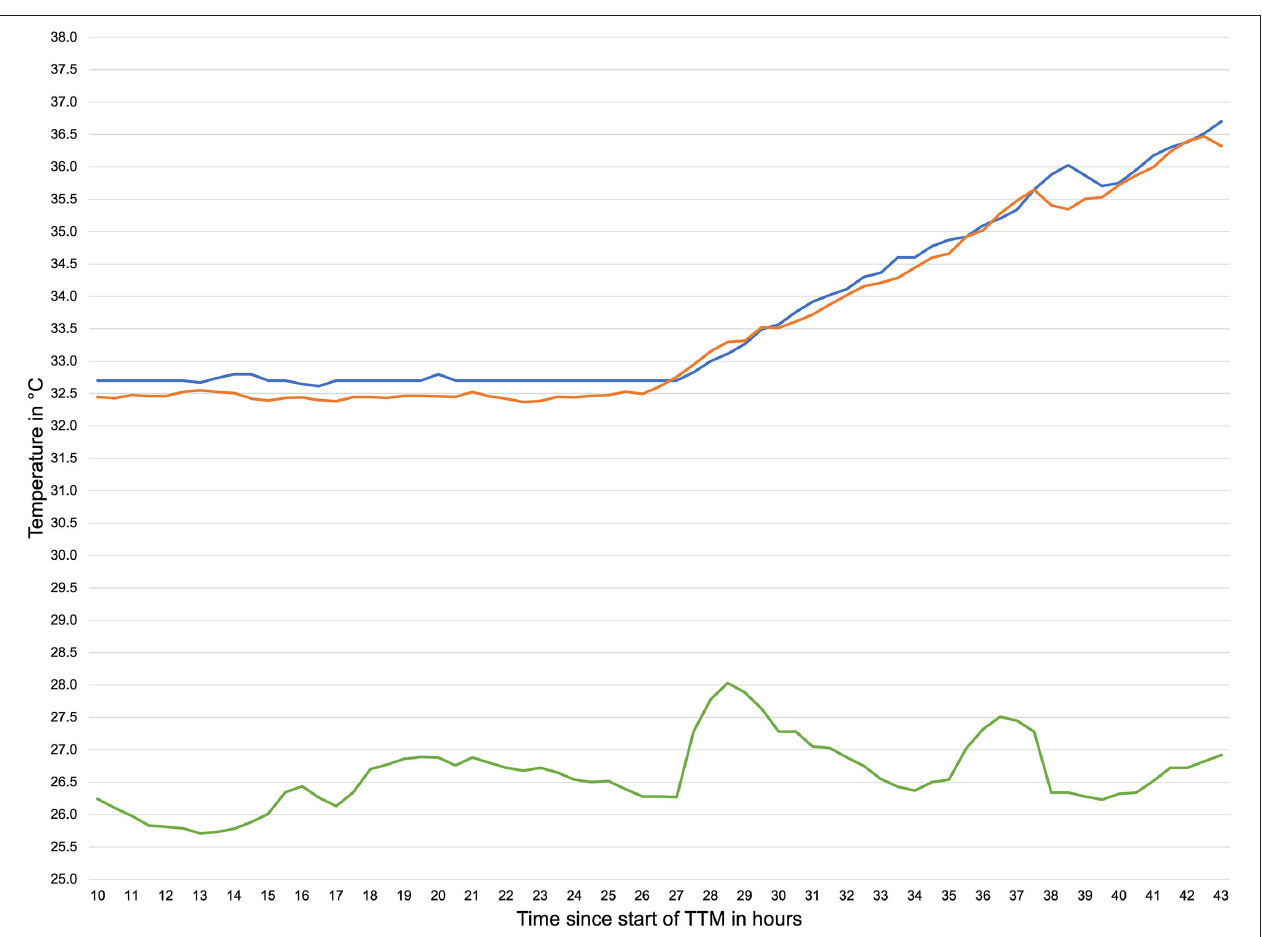
FIGURE 3 | Exemplary temperature profile during TTM. orange line: temperature measured by double sensor, blue line: temperature measured by esophageal thermometer, green line: ambient temperature.